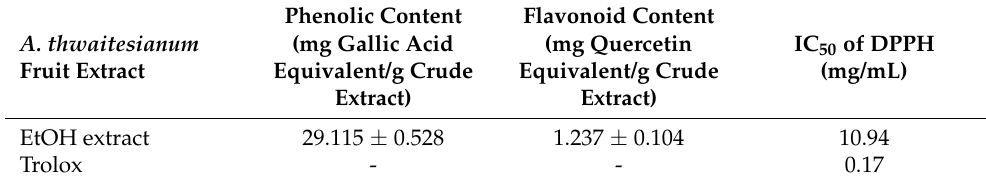
Table 2. IC 50 DPPH and total phenolic and flavonoid contents of the A. thwaitesianum fruit